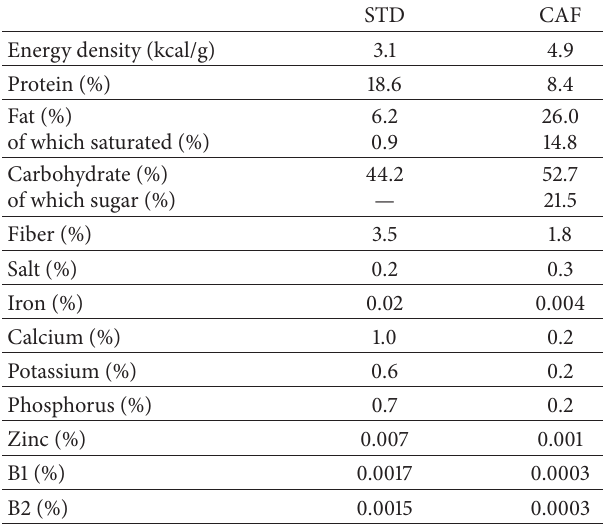
Table 1: Composition of the standard and cafeteria